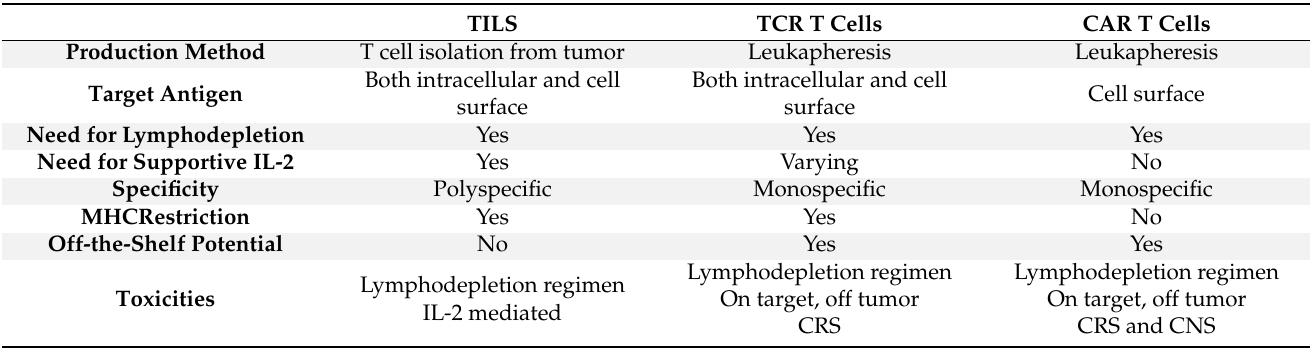
Table 1. Comparison of the main ACT products. Table based on Rohaan et al. 2018 [48]. TILs: tumor-infiltrating lymphocytes; TCR: T cell receptor; CAR: Chimeric antigen receptor; CRS: cytokine release syndrome; CNS: central nervous system.